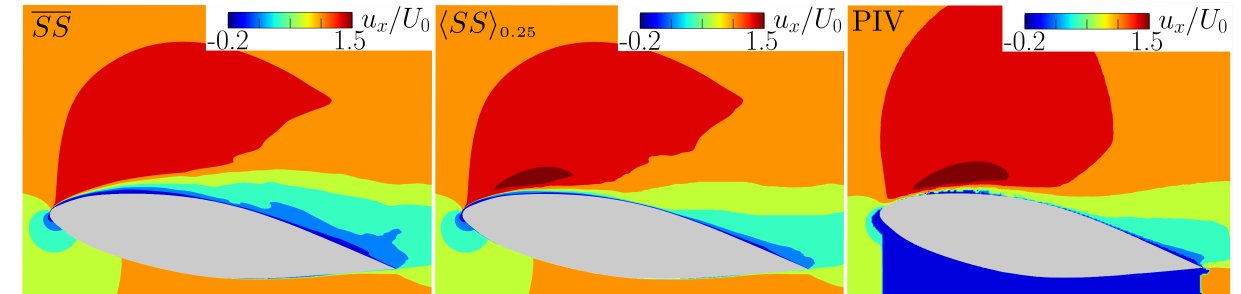
Figure 5. Comparison of experimental and numerical fields of the streamwise component of the time-averaged velocity for regime I in longitudinal midspan section of hydrofoil. Results of the Schnerr-Sauer (SS) model with LUDS discretization scheme for convective term in momentum equation are presented for time-averaging ( . ) and conditional averaging procedures according to Equation (21). The threshold value of ˜ α th is chosen equal to